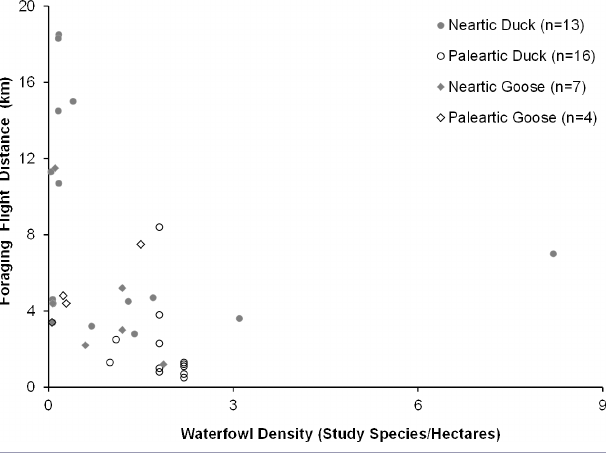
), and the change in AIC from the smallest AIC value (∆AIC ), and c c c c